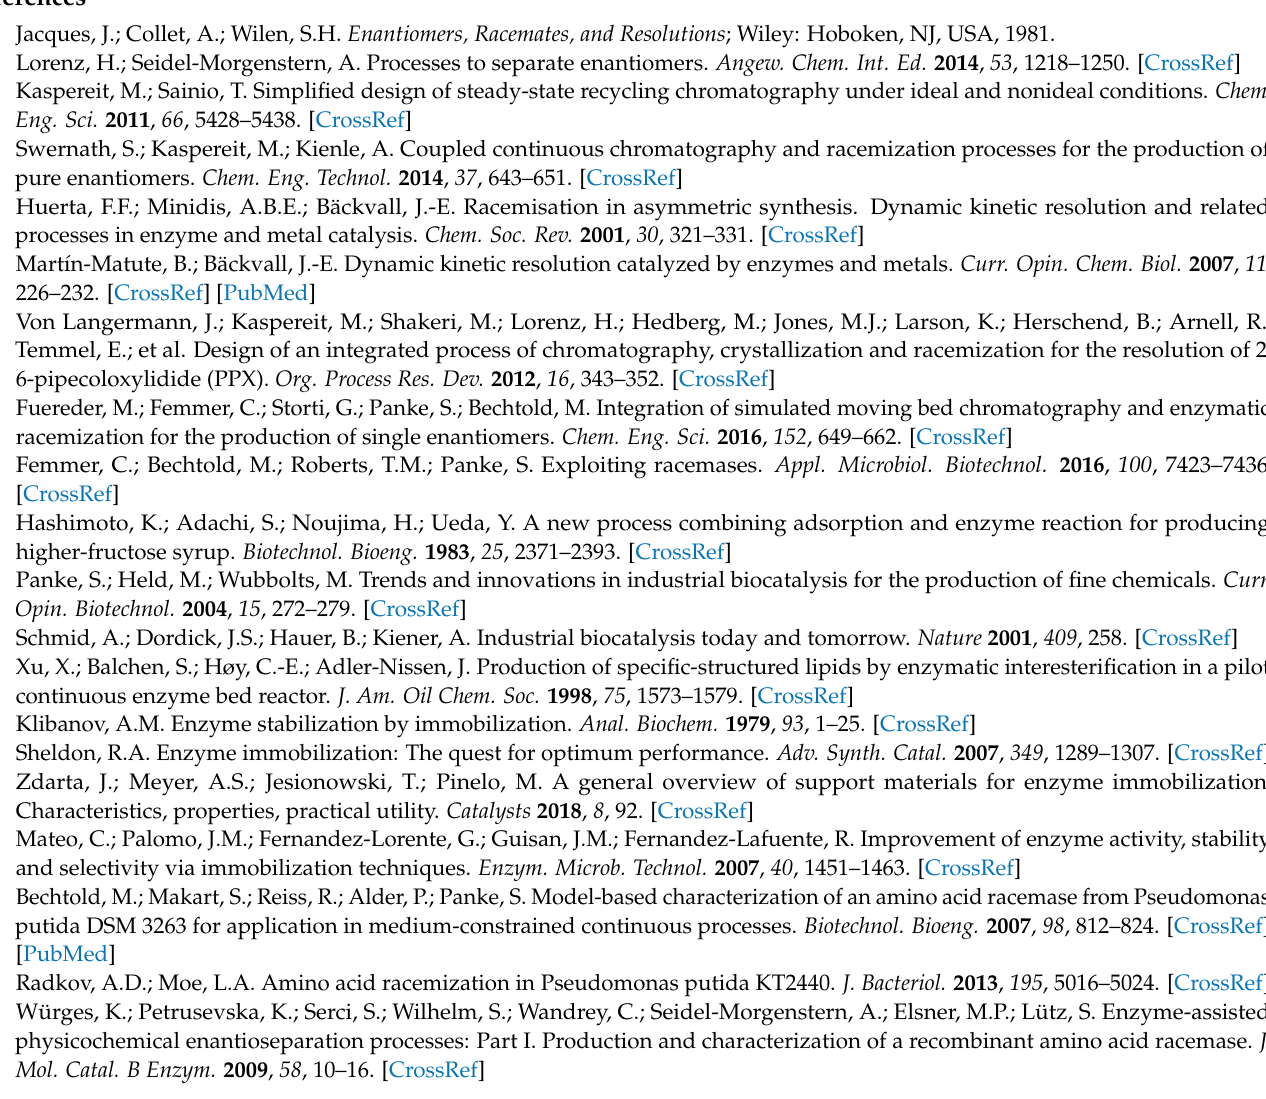
Figure S2: The MM coefficients r max and K M at different reaction. Figure S3: Activity of the